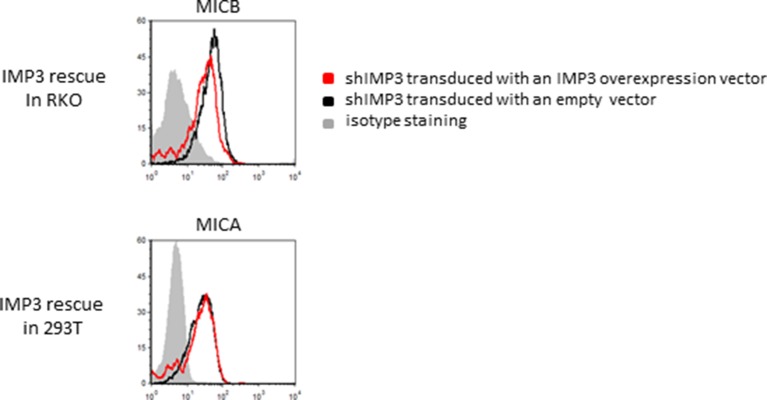
Rescue IMP3 in RKO and 293T shIMP3 cells reverses MICB downregulation but does not affect MICA expression.RKO and 293T cells transduced with a shRNA targeting IMP3 were selected using puromycin and subsequently transduced with a plasmid coding for IMP3. FACS analysis of stress-ligand expression MICB and ULBP2 for RKO cells or MICA and ULBP2 in 293T cells is shown. As shown before, MICA is not expressed on RKO cells and 293T cells are negative for MICB. RKO and 293T shIMP3 cells were transduced with either with an empty vector (black histogram) or rescued with an IMP3 expression plasmid (red histogram). The grey filled histogram is the background staining determined for an isotype mouse IgG antibody. Figure shows each one representative plot out of three experiments performed.